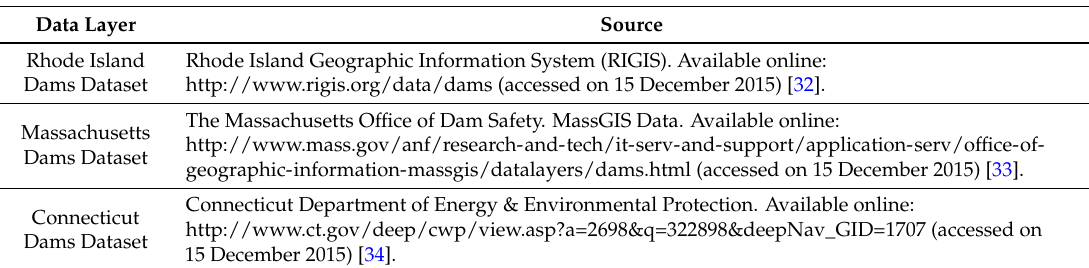
Table 1. New England Dam and Geospatial Data Source Information.